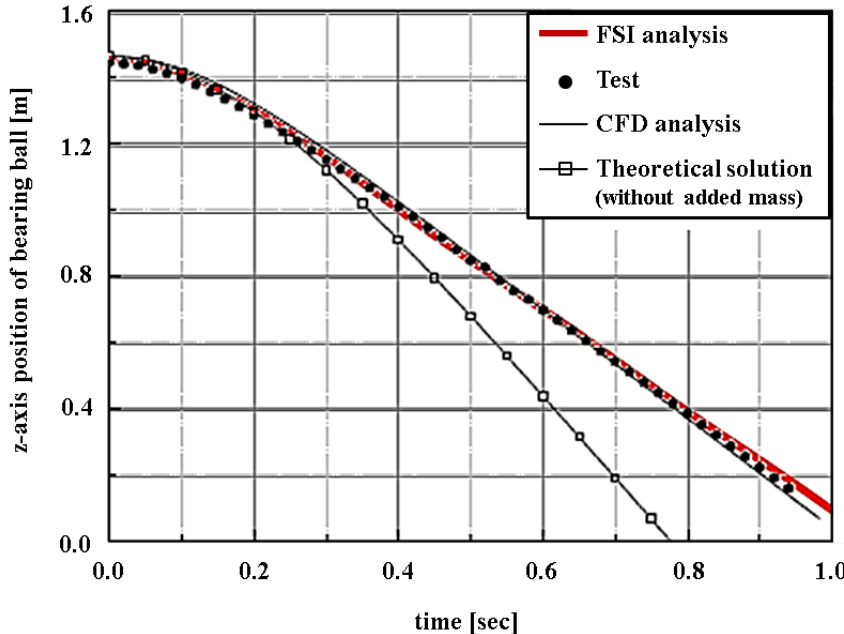
Figure 7. Comparison results for underwater drop test of bearing steel sphere.